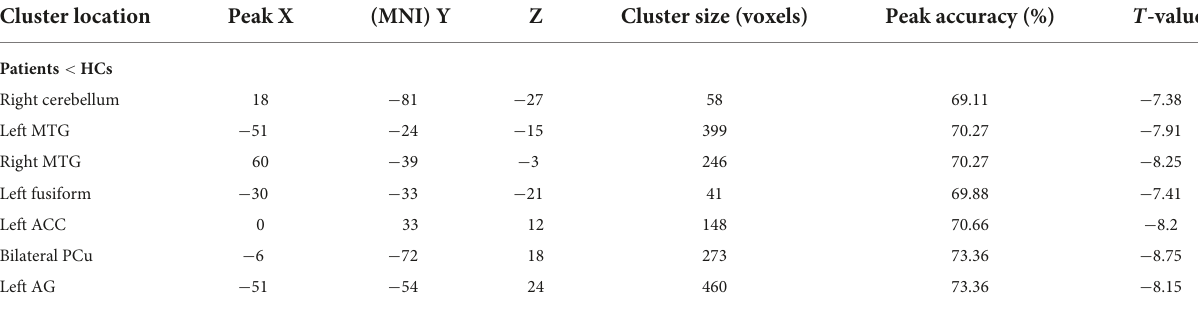
TABLE 2 Brain regions with abnormal ALFF in schizophrenia patients.